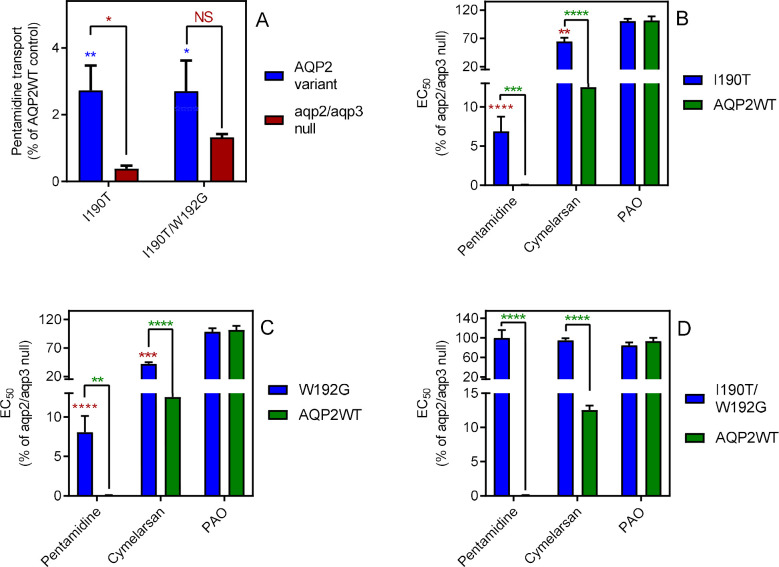
Mutational analysis of TbAQP2 residues I190 and W192.(A) Transport of 30 nM [3H]-pentamidine by tbaqp2/tbaqp3 null cells or TbAQP2 variants expressed therein. Transport was expressed as a percentage of the rate of the AQP2WT control, performed in parallel. Blue stars are comparison with TbAQP2WT, red stars, comparison with the tbaqp2/tbaqp3 null control. NS, not significant. (B) EC50 values for the indicated drugs against tbaqp2/tbaqp3 null cells, and against TbAQP2WT and TbAQP2I190T expressed therein; values were expressed as % of the tbaqp2/tbaqp3 null (resistant) control. Red stars, comparison with the resistant control; green stars, comparison with the internal sensitive control (TbAQP2WT). The assays for all three strains and all three drugs were done simultaneously on at least three different occasions. (C) As B but for TbAQP2W192G. (D) As B but for TbAQP2I190T/W192G. All data for these graphs are contained in Figure 3—source data 1. *, p<0.05; **, p<0.01; ***, p<0.001, ****, p<0.0001 by unpaired Student’s t-test.Figure 3—source data 1.Individual and average EC50 values and transport rates for Figure 3A-D and Figure 3—figure supplement 1.